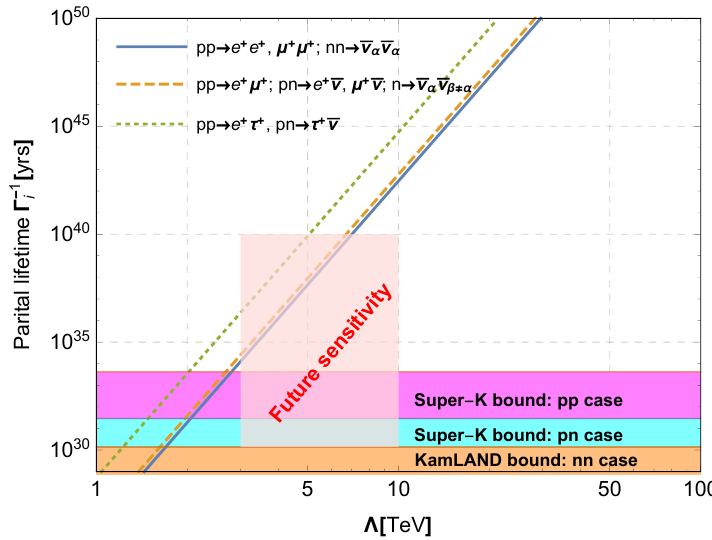
Figure 2 . The partial lifetime of the dinucleon to dilepton transitions as a function of the NP scale in the SMEFT. Where we assume the contribution from operator O S, ( S )